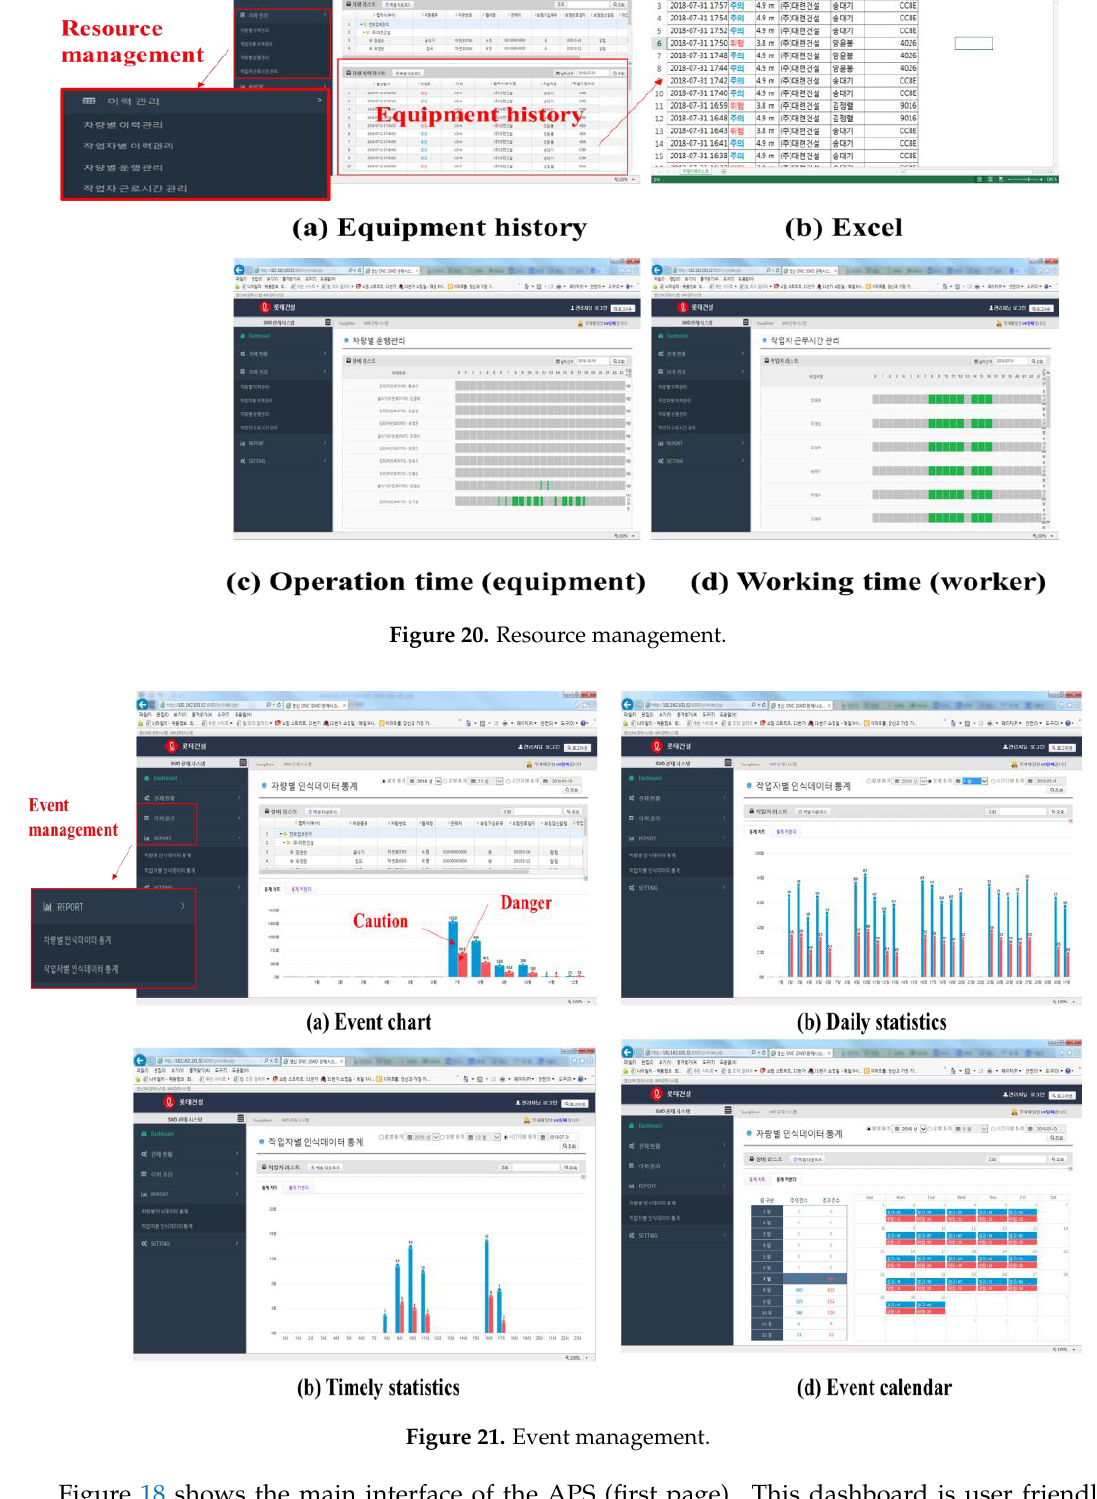
Figure 21. Event management.